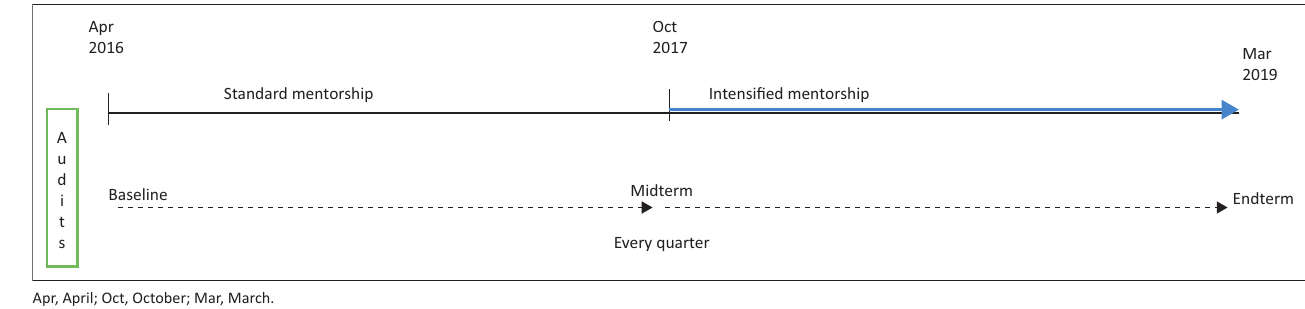
FIGURE 2: Timeline of the evaluation of 27 laboratories starting April 2016 to March 2019,